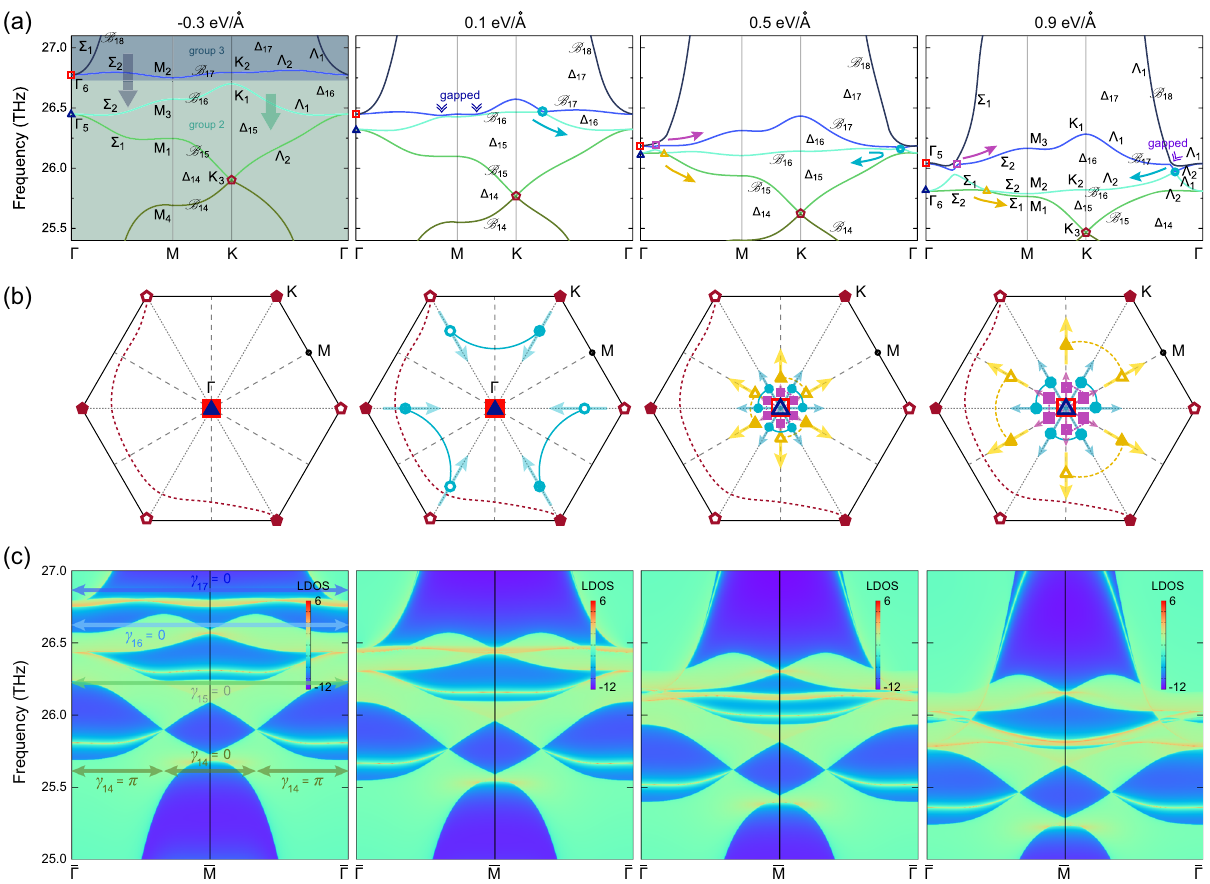
Fig. 4 Braiding of phonons in groups 2 and 3. a Phonon branches B 14 (cid:2) 18 and their corresponding nodes of 5% strained silicate under electric fi elds of − 0.3 eV/ Å , 0.1 eV/ Å , 0.5 eV/ Å , and 0.9 eV/ Å . The panels in b show the nodes and their topological charges. As before, different symbols characterise topological charges in different gaps, whereas open versus closed symbols indicate the sign of the charge. Dirac strings are drawn as lines. The large blue triangles and the large red squares at Γ are quadratic nodes. The corresponding phonon edge states on the (100) edge are shown in ( c ), with the {0, π }- quantised Zak phases f γ n g n for the gaps f Δ n g n indicated by the ¼ 14 ; ¼ ; 17 ¼ 14 ; ¼ ; 17